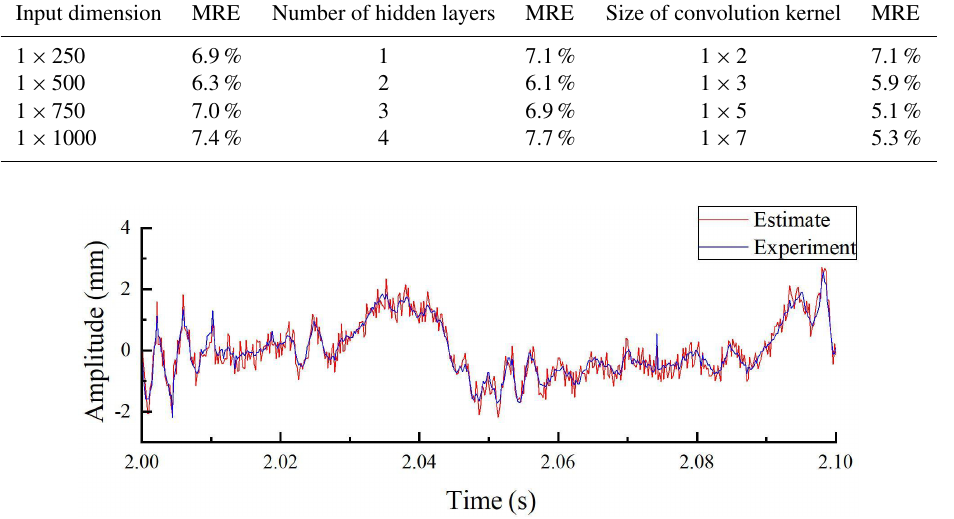
Figure 9. Training results of convolutional neural